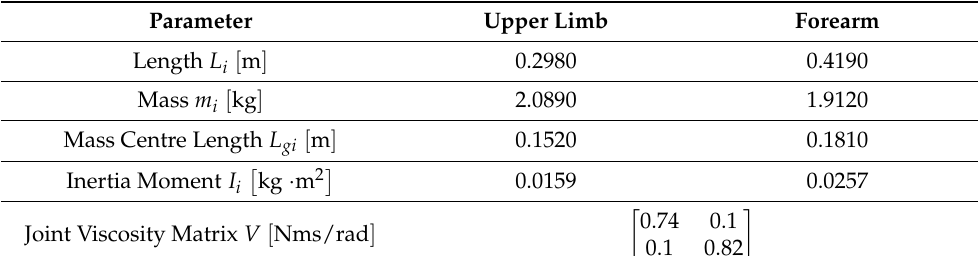
Table 3. Biophysiological parameters of the musculoskeletal arm